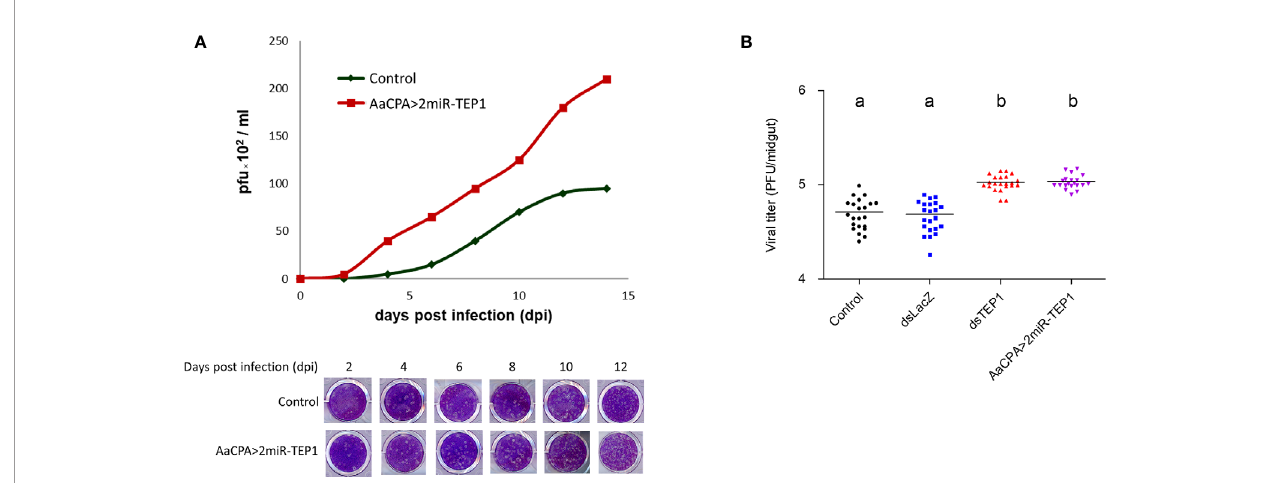
FIGURE 4 | Thioester-Containing Protein 1 (TEP1) Transgenic Mosquito Enhances Dengue Virus (DENV) Infection. (A) Aedes aegypti control and loss-of-function transgenic (AaCPA>2miR-TEP1) mosquitoes were fed an infectious DENV blood meal. The whole bodies of infected mosquitoes were collected 0, 2, 4, 6, 8, 10, and 12 days after the infectious blood meal and viral titers were determined and quanti fi ed with a plaque assay. (B) Ae. aegypti mosquitoes with silenced TEP1 or mosquitoes from the loss-of-function transgenic line were fed an infectious DENV blood meal. Midguts from infected mosquitoes were collected seven days after the infectious blood meal and the viral titers were determined by plaque assay. Letters indicate the statistical signi fi cance according to Tukey ’ s multiple comparison test. There is no signi fi cant difference between them ( p > 0.05). Control: Aedes aegypti UGAL/Rockefeller strain without any transgenic materials or dsRNA treatment.